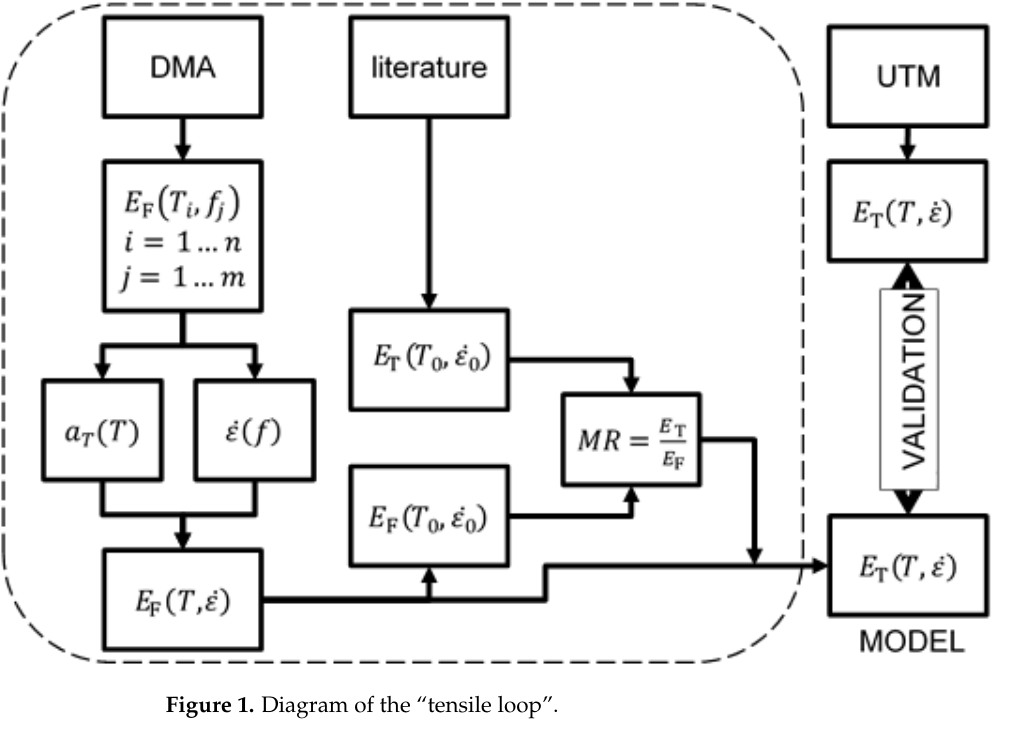
Figure 1. Diagram of the “tensile loop”.